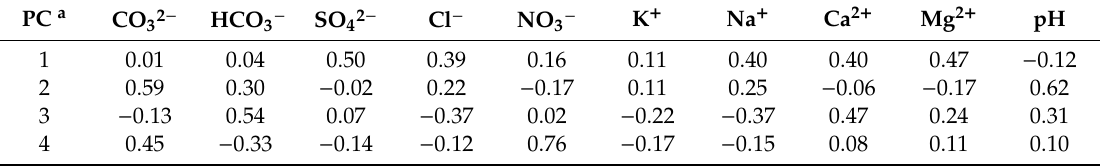
Table 3. Load matrix of first four principal components of soil